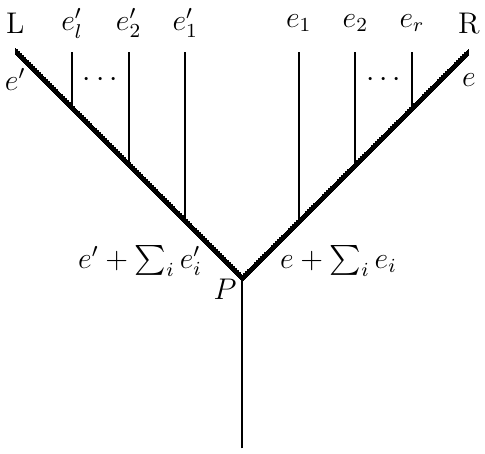
Figure 3 . Diagrammatic representation of a scattering process in which an incoming closed string state carrying energy ω 1 splits into a set of right sector closed strings carrying energies e 1 , · · · , e r , a set of left sector closed strings carrying energies e 0 , · · · , e 0 and a fermion hole pair, one on each side 1 l of the potential barrier. The time flows up, the thin lines denote the external closed strings and the thick lines denote fermions and holes. There are two distinct diagrams, one where the left sector state is a fermion and the right sector state is a hole and vice